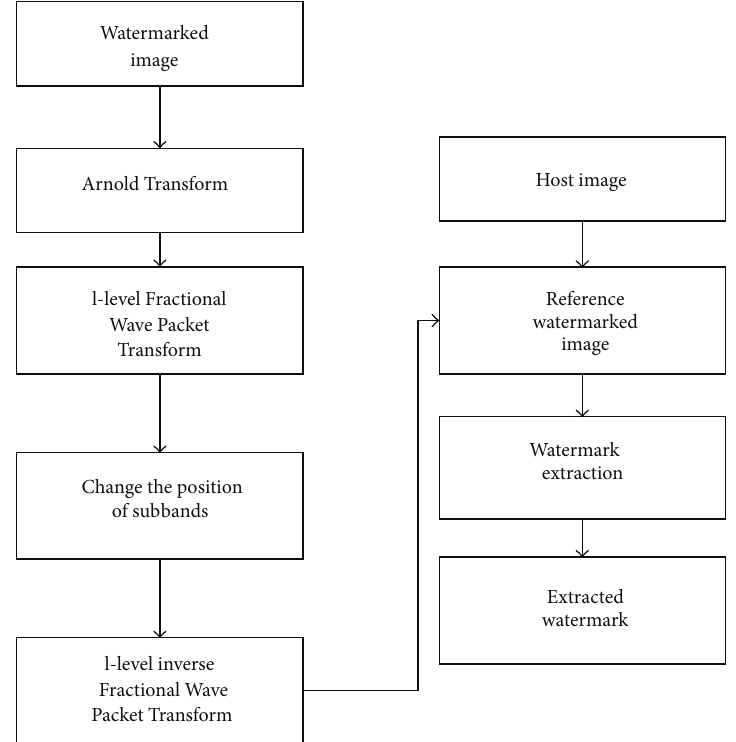
Figure 3: Watermark extraction process.